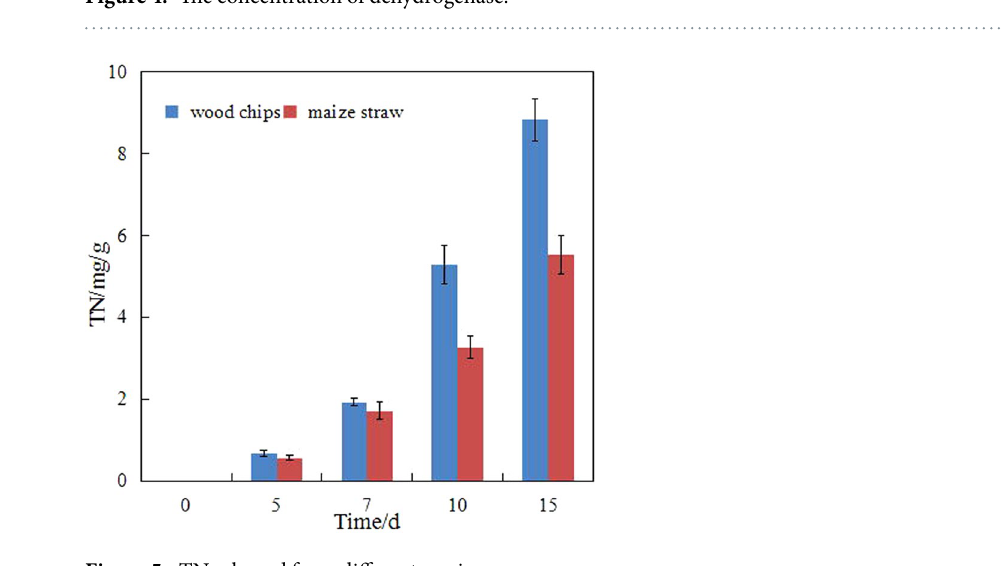
Figure 5. TN released from different carriers.